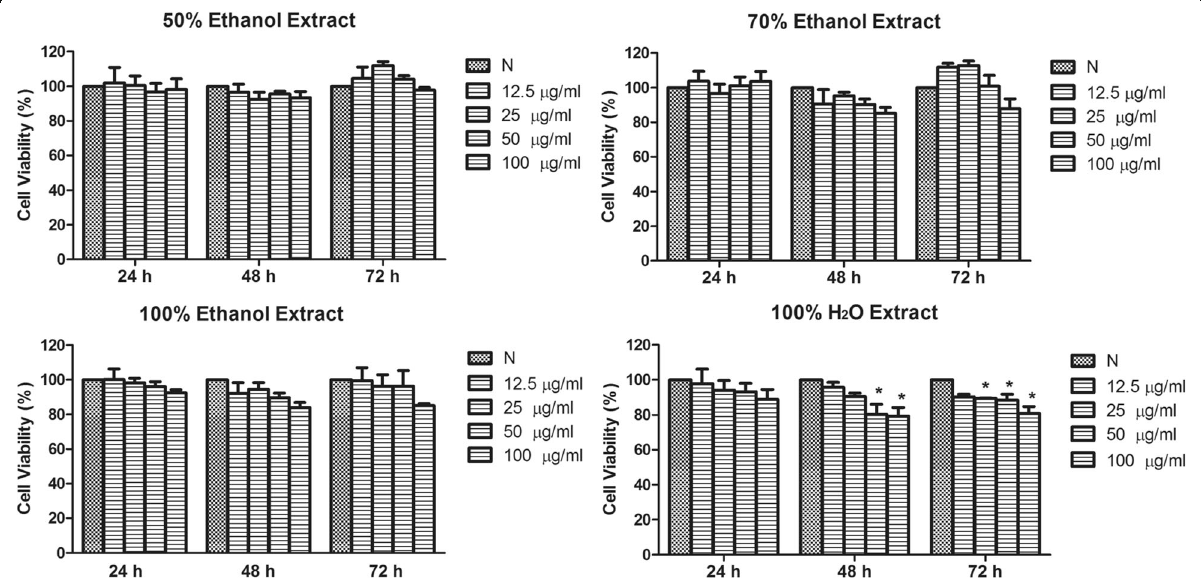
Fig. 1 Effects of 50, 70, 100% ethanol extracts and 100% water extract of C. nutans leaves on endothelial cell proliferation at 24, 48 and 72 h. The water extract of C. nutans leaves was chosen for subsequent experiments. The values presented are the mean±SEM of three independent experiments and compared against normal control (N). * p <0.05 were considered